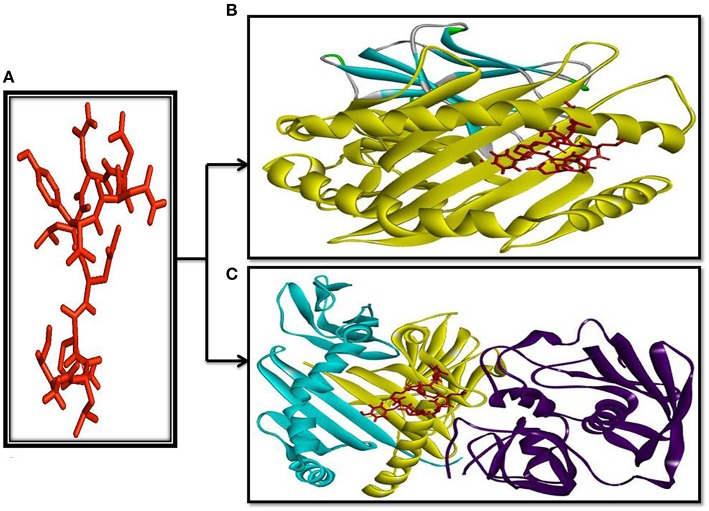
Docking simulation study. Structure of the predicted epitope SU1‘TLKNLNDNY’ (Red stick) (A) and visualize of docking results of SU1 with MHC-I (HLAB*15:01); Chain A-yellow, Chain B-Bluish (B) as well as with MHC-II (HLA-DR) (C) Chain A-Yellow, Chain B-Bluish, Chain C-Blue.